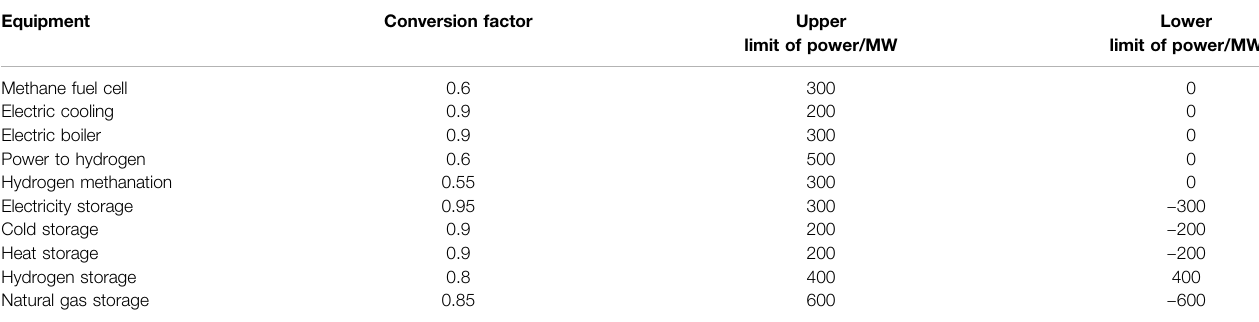
Frontiers in Energy Research |